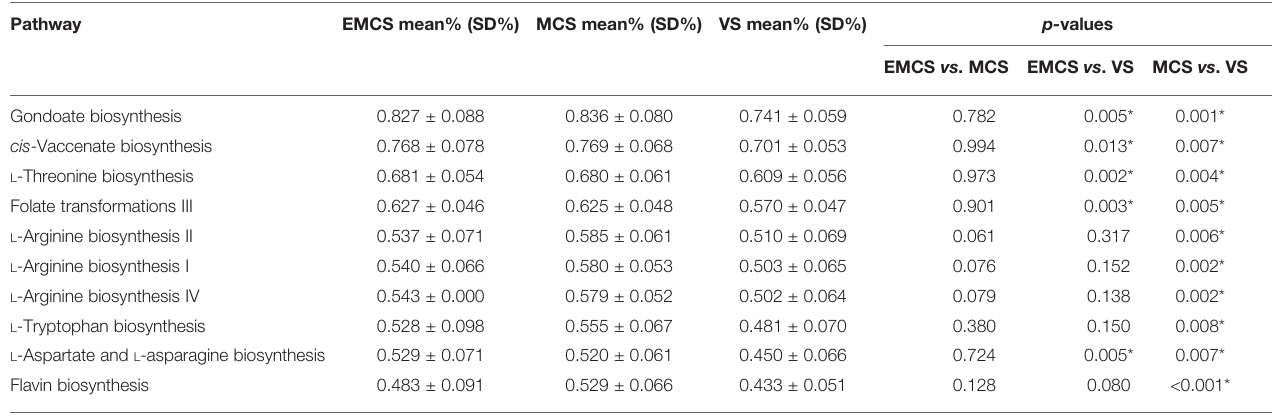
TABLE 2 | Pathway analysis of the EMCS, MCS, and VS groups using PICRUSt2.